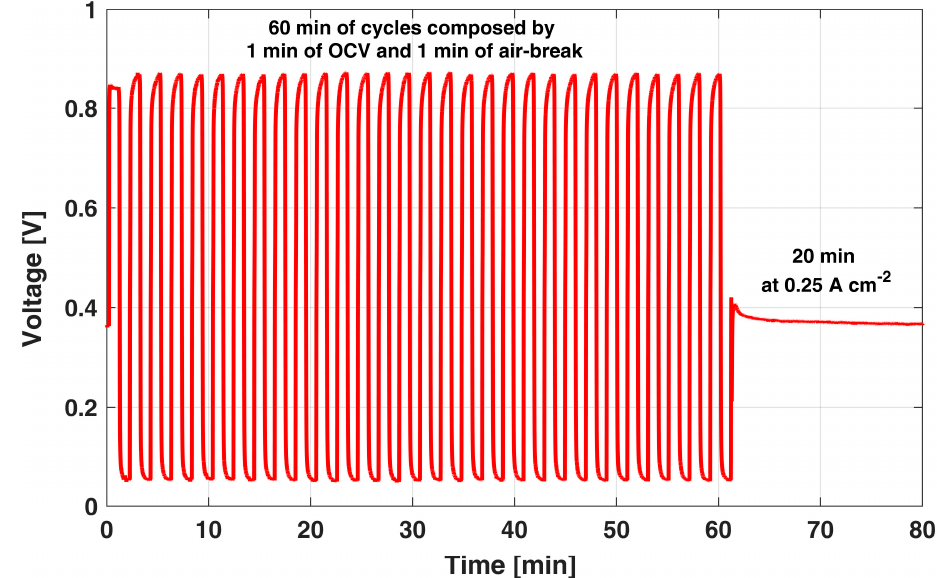
Figure 2. Sample of the OCV and air-break cycles used as AST.